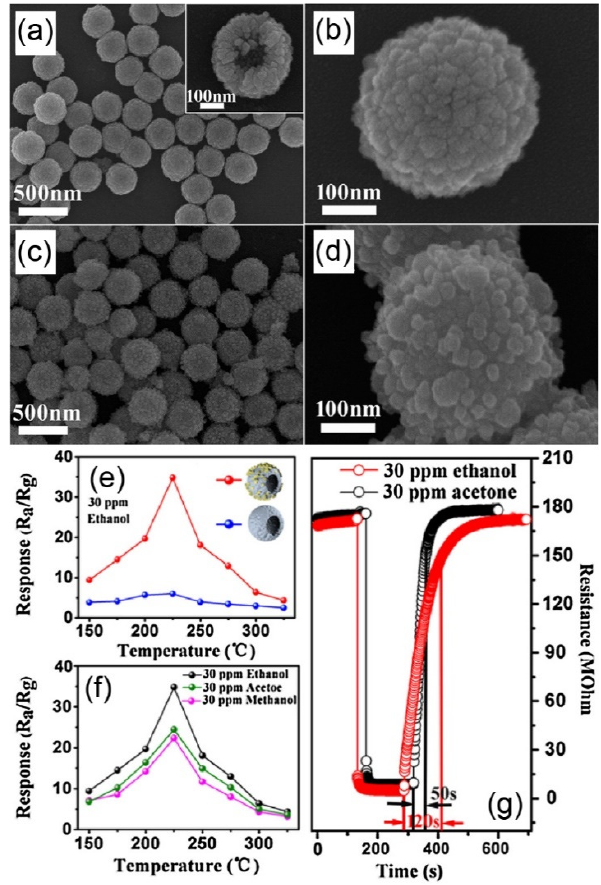
Figure 3. SEM images of the pure SnO 2 hollow spheres ( a , b ) and ZnO-decorated SnO 2 (n-n junctions) ( c , d ), sensor response of pure SnO 2 hollow spheres and the ZnO-decorated SnO 2 hollow spheres to 30 ppm ethanol at different operating temperatures ( e ), the sensor response of ZnO-decorated SnO 2 hollow spheres to 30 ppm ethanol, acetone and methanol at different operating temperatures ( f ), and the dynamic sensing performance of the decorated SnO 2 hollow spheres towards 30 ppm ethanol or acetone at 225 °C ( g ). Copied with permission from reference [39]. Copyright 2017, Elsevier.